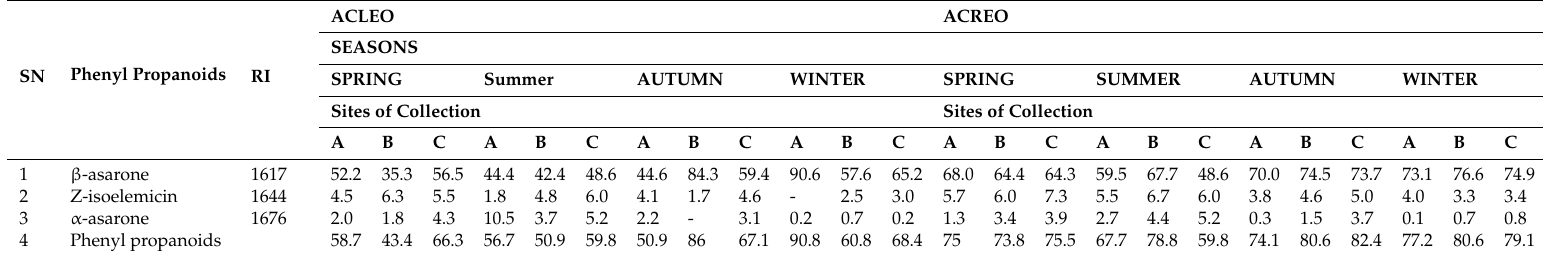
Table 2. Phenylpropanoids in ACLEO and ACREO in different seasons from different altitudes.